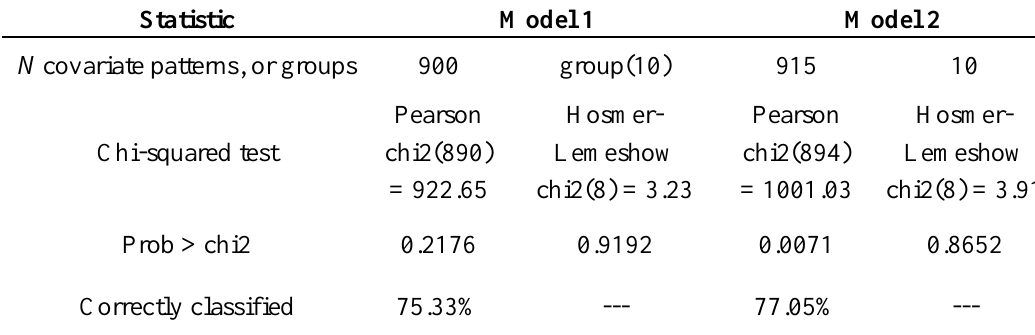
Table A1. Diagnostics for Regressions on Sustainable Seafood Scenario (see Table